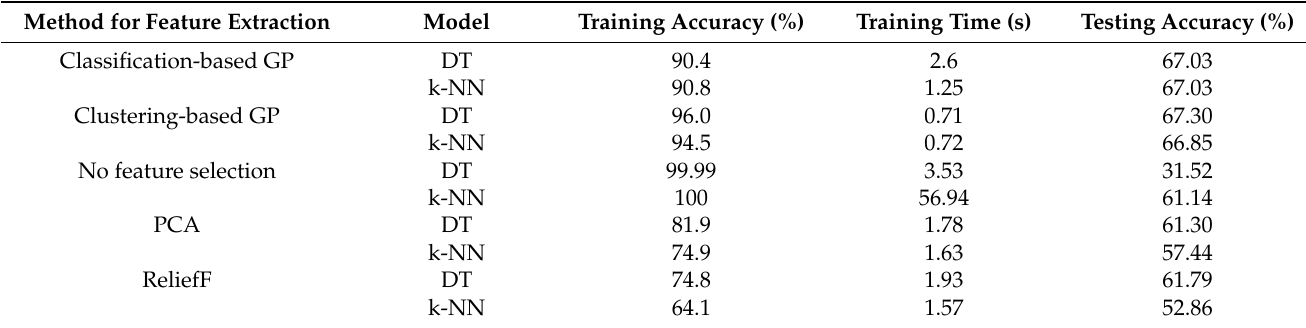
Table 8. Classification